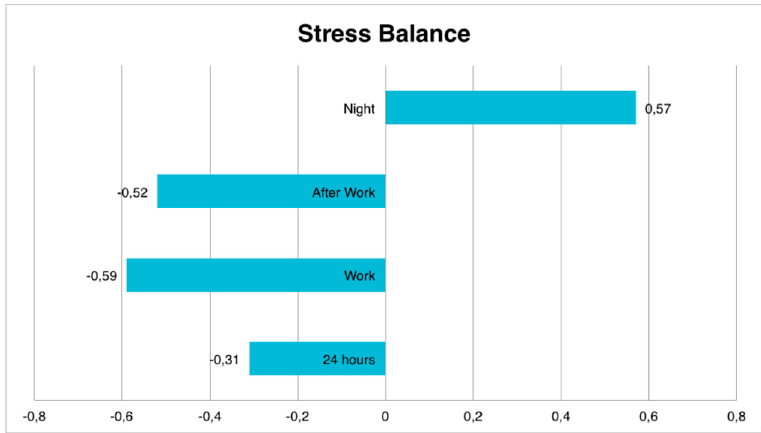
Figure 7. Stress balance for different time slots.